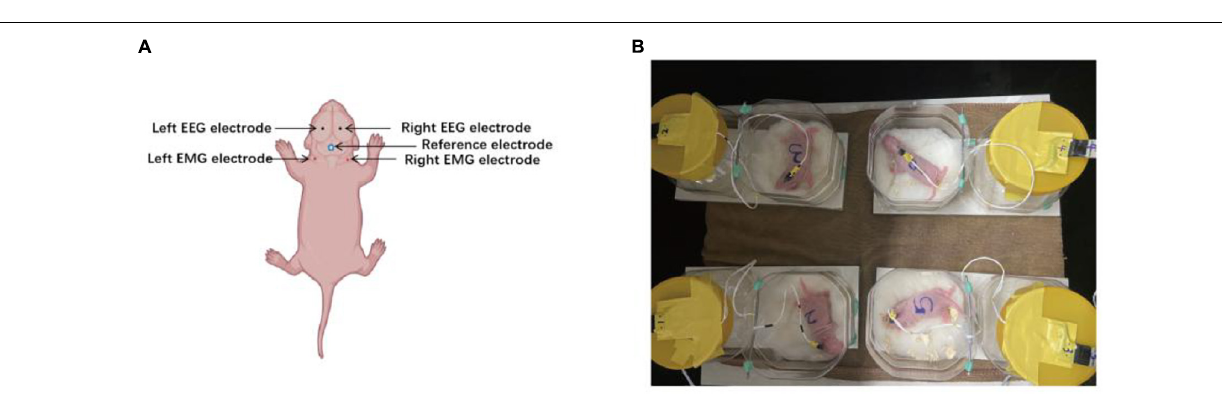
FIGURE 2 | Location of electrodes placement and electroencephalography (EEG) monitoring. (A) Two silver electrodes were implanted bilaterally in the parietal cortex for EEG recording. The black dots are the location of the EEG electrodes. Two insulated stainless-steel wire electrodes were inserted bilaterally into the neck muscle for nuchal electromyography (EMG) recordings. The right dots are the location of the EEG electrodes. The blue-circled dots denote the location of reference electrode. (B) The signals from multiple receivers were collected and stored at a sampling rate of 1,000